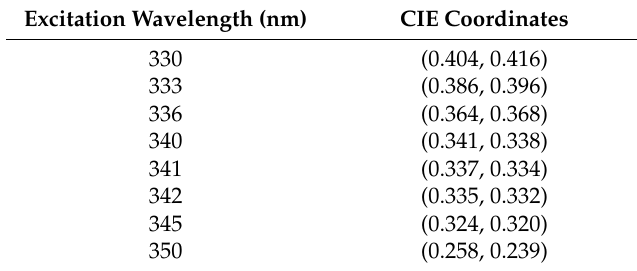
Figure 8. (a) Excitation spectra of complex c with two different emission wavelengths. Emission spectra (b) and CIE chromaticity diagram (c) of complex c by excitation wavelength from 330 to 350 nm (shown in fork symbols from right to left, referring to the excitation wavelength at 330, 333, 336, 340, 341, 342, 345, 350 nm, respectively). (d) The fluorescence decay curves of BCPs-Ln 3+ -Phen (a. 5 D 0 - 7 F 2 transition of Eu 3+ ions, b. 5 D 4 - 7 F 5 transition of Tb 3+ ions). Table 4. CIE coordinates of BCPs-Ln 3+ -Phen under different excitation